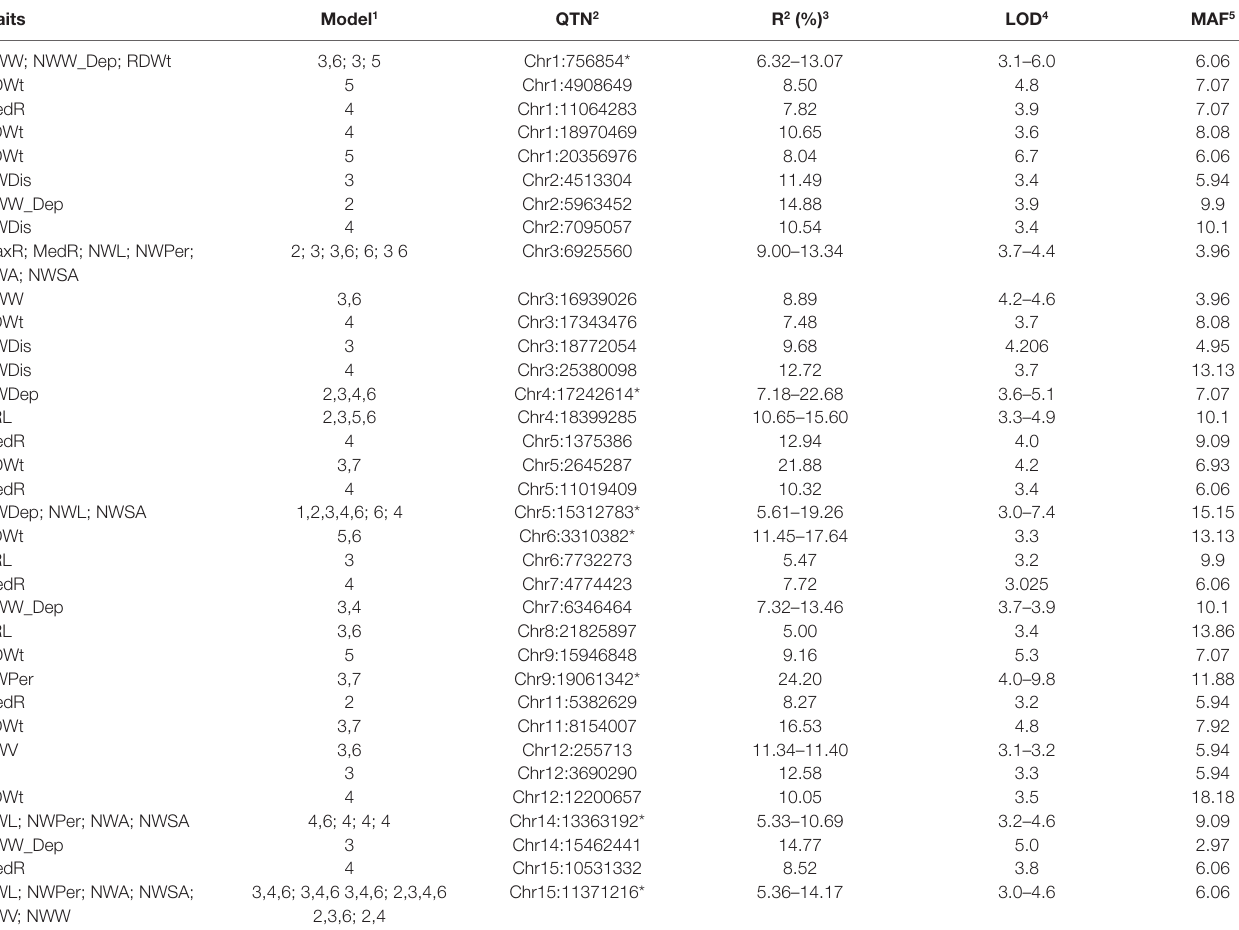
TABlE 3 | QTNs with high phenotypic variance explained (R 2 > 5%). Traits Model